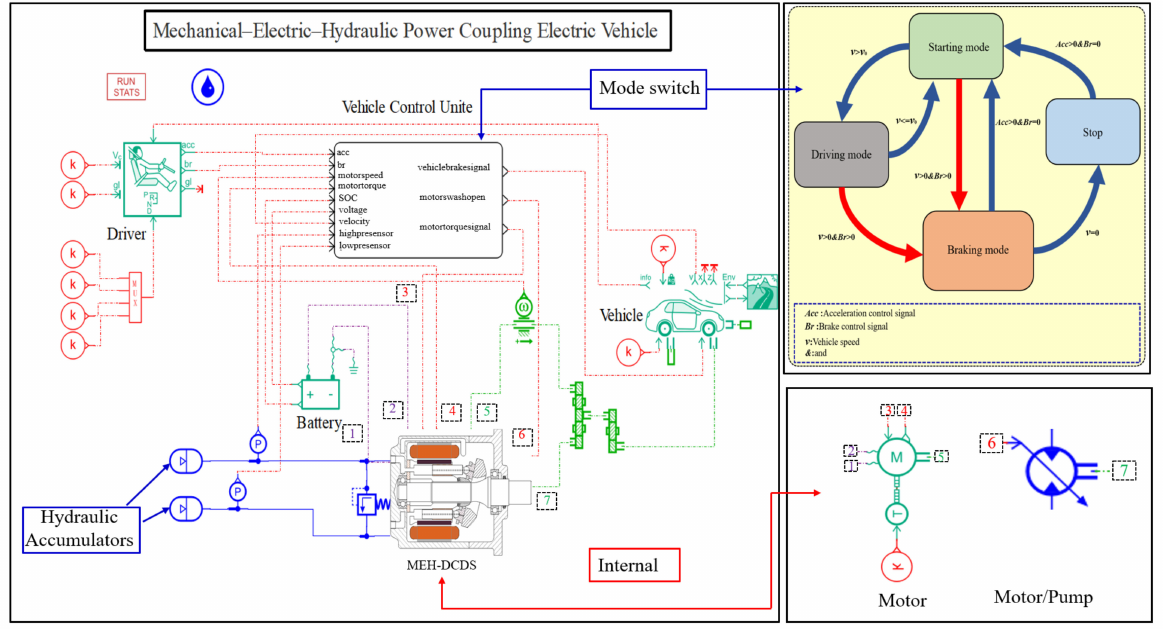
Figure 10. Whole vehicle simulation